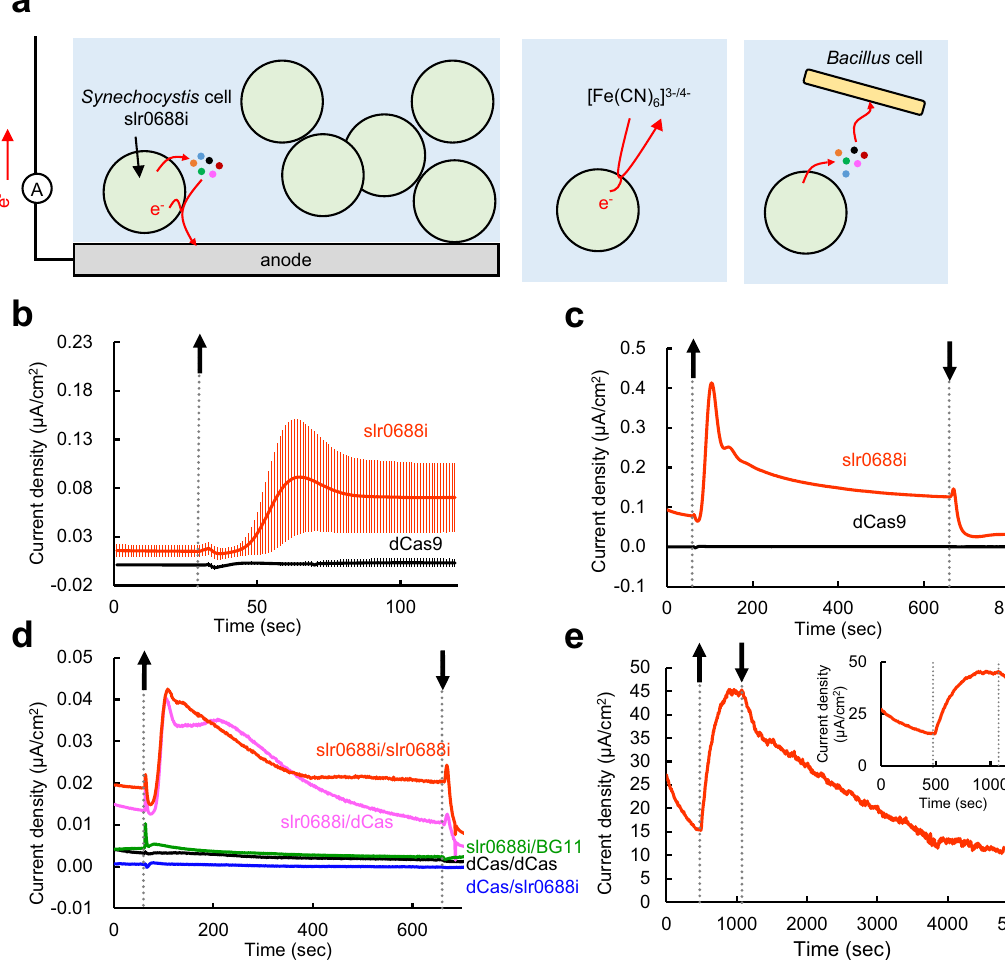
Fig. 1 EET and photocurrent generation from Synechocystis cells. a Schematic summary of EET from outer membrane-deprived Synechocystis cells, slr0688i. From slr0688i, reducing equivalents could be transferred to an exterior electrode via secreted compounds (mediated EET) or to an arti fi cial electron acceptor, ferricyanide (ferricyanide-mediated EET). In addition, the extracellularly derived reducing equivalents could serve as respiratory substrates for other bacteria (here, Bacillus cereus ), i.e., electron donors in BPV systems. b Slr0688i (OD 730 = 1.5, 4 mL; red points) and dCas9 (OD 730 = 1.5, 4 mL; black points) were injected by gravity onto plane ITO electrodes, and + 0.25 V vs Ag/AgCl was applied to obtain chronoamperograms. Averages ± 2 SE from 33 and 21 biological replicates for slr0688i and dCas9, respectively, are presented. c Representative chronoamperograms of slr0688i (OD 730 = 1.5, 4 mL; red line) and dCas9 (OD 730 = 1.5, 4 mL; black line). d The supernatant of slr0688i was substituted either with that of dCas9 (pink line) or with fresh BG11 medium (green line). Also shown as controls are slr0688i and dCas9 suspended in their respective supernatants (red and black lines, respectively), and dCas9 in slr0688i supernatant (blue line). All cell suspensions were adjusted to OD 730 = 1.5 (4 mL) and injected onto fl at ITO, and + 0.25 V vs Ag/AgCl was applied. e Slr0688i (OD = 14.6, 4 mL) after 6 days of culture were injected by gravity onto a piece of carbon paper placed 730 upon fl at ITO, and + 0.25 V vs Ag/AgCl was applied. The inset shows the enlarged view from 0 to 1200 s of the measurement. The upward and downward arrowheads indicate the beginning and end of illumination ( b – d , 100 µ mol photons m − 2 s − 1 ; e, 420 µ mol photons m − 2 s − 1 ), respectively. Source data are provided as a Source Data fi